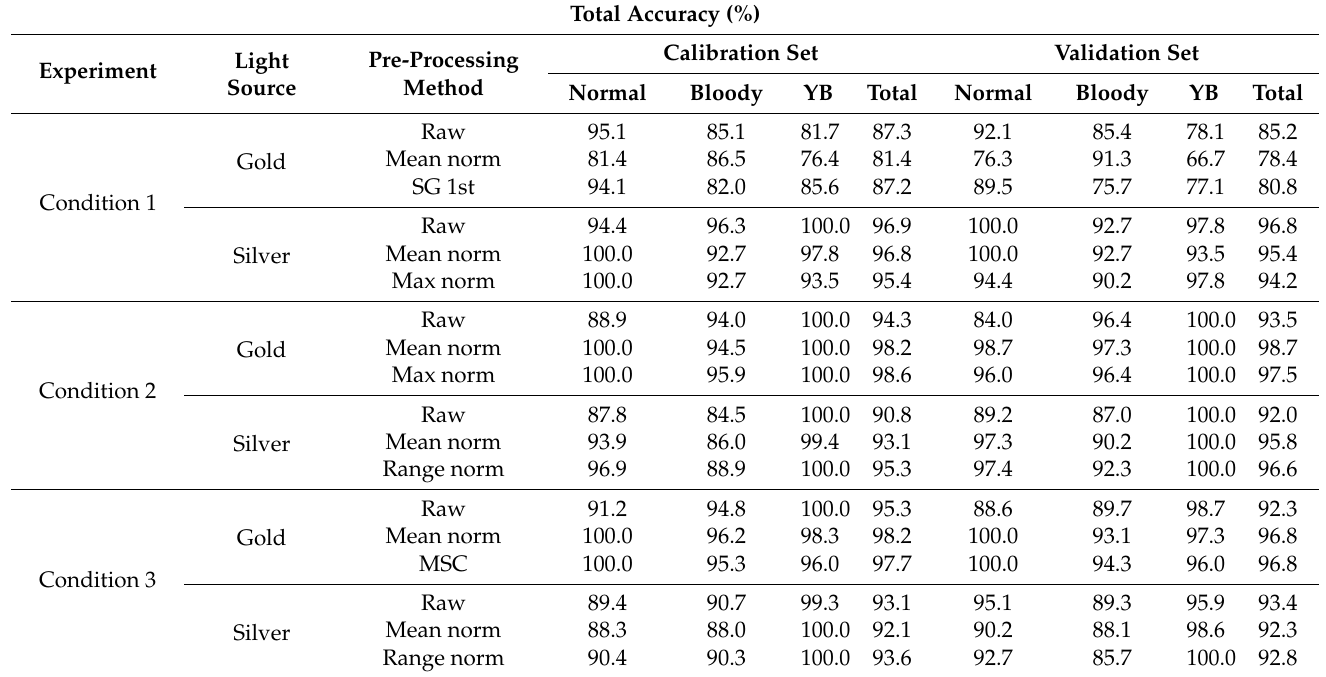
Table 1. The whole spectrum range PLS-DA model using the different light sources (gold and silver) for abnormal eggs classification.